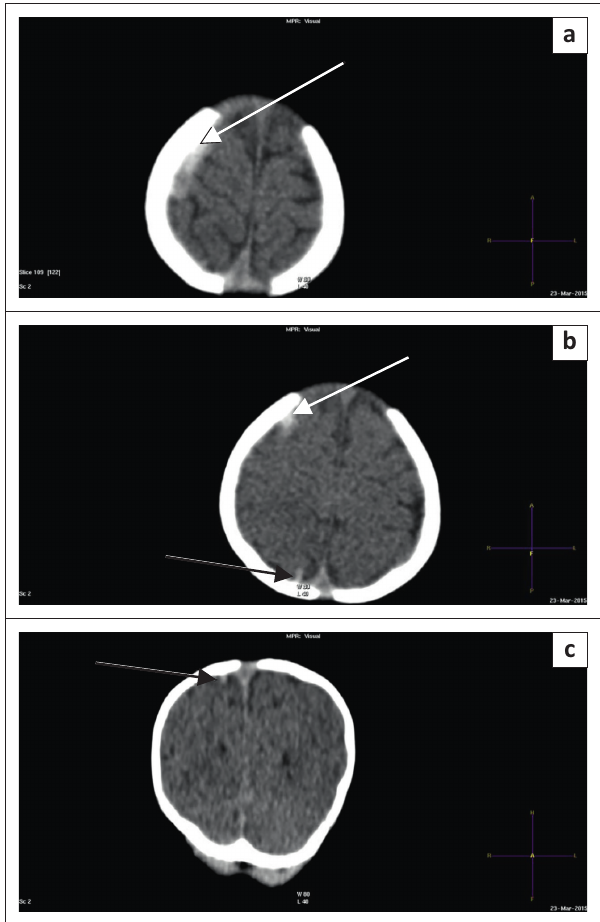
FIGURE 7: (a) A 5month old infant presented with failure to thrive, and new onset seizures. Axial CT brain demonstrated an acute right frontal subdural haematoma (white arrow); (b) Tubular hyperdensity in the right high parietal lobe, consistent with a cortical vein thrombosis (black arrow). The acute right frontal subdural haematoma (white arrow) is also demonstrated on this slice; (c) Coronal MPR CT brain confirms the high /vertex location of the bridging vein thrombosis (black